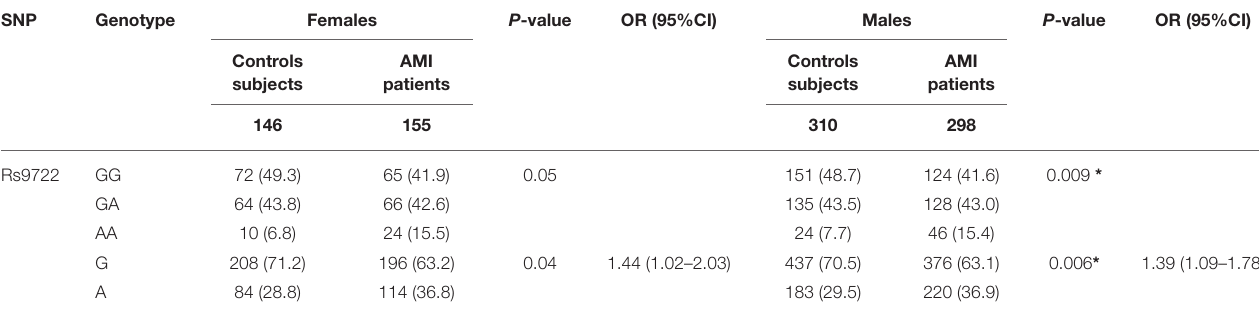
Controls AMI subjects patients